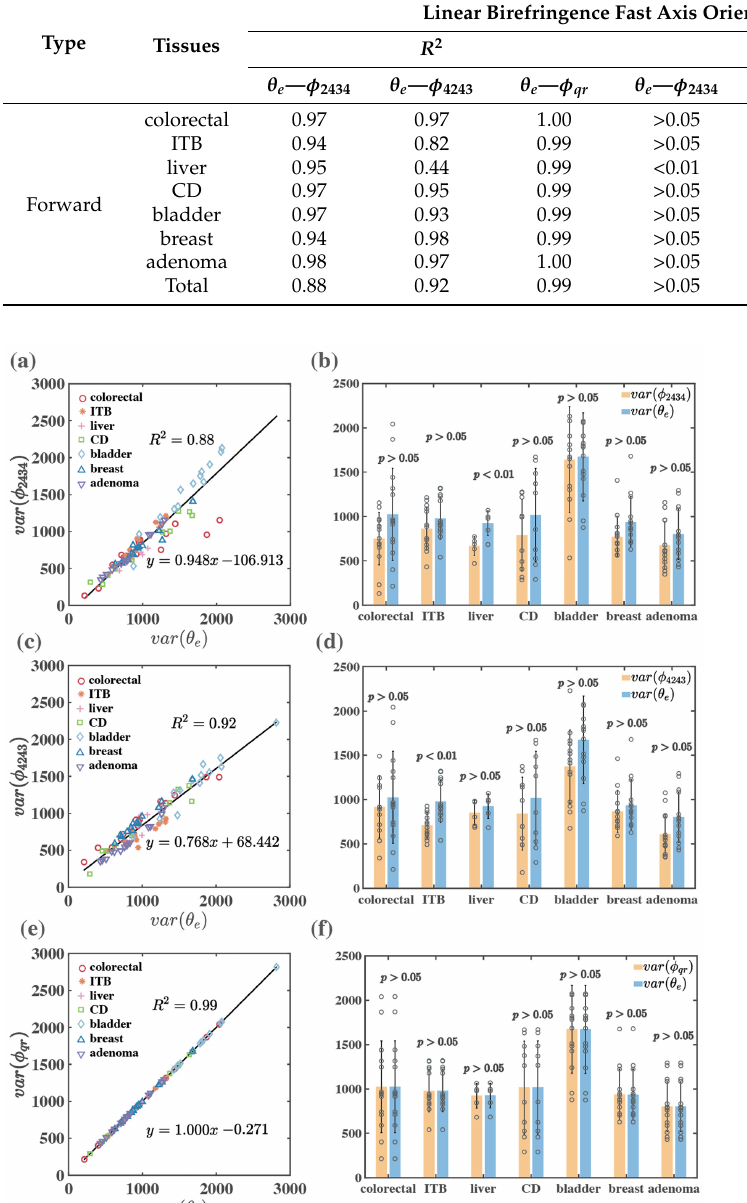
Table 6. Correlation and statistical analysis comparison results between forward measured MMT and MMPD linear birefringence orientation parameters for each kind of thin tissue samples.